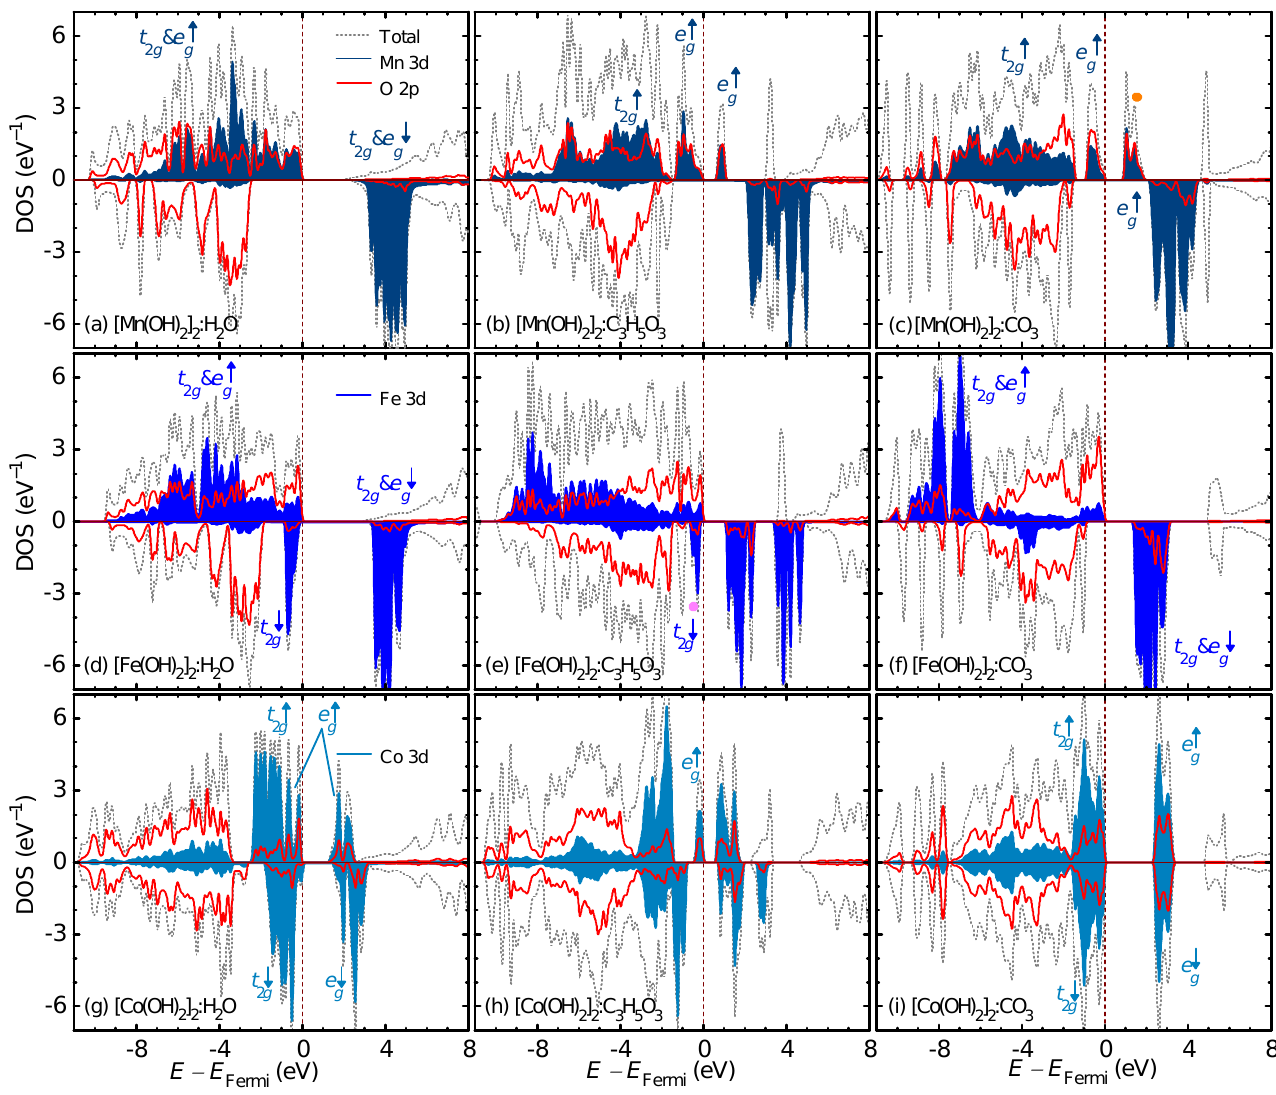
Figure 3. Total and partial density of state of the intercalated layered double hydroxide compounds. The upper row of ( a – c ) corresponds to the Mn-based compounds. The middle row of ( d – f ) corre- sponds to the Fe-based compounds. The lower row of ( g – i ) corresponds to the Co-based compounds. The first, second, and third columns correspond to H 2 O, C 3 H 5 O 3 , and CO 3 intercalation. The 3d partial density of states of different TM ions is shown in various shades of